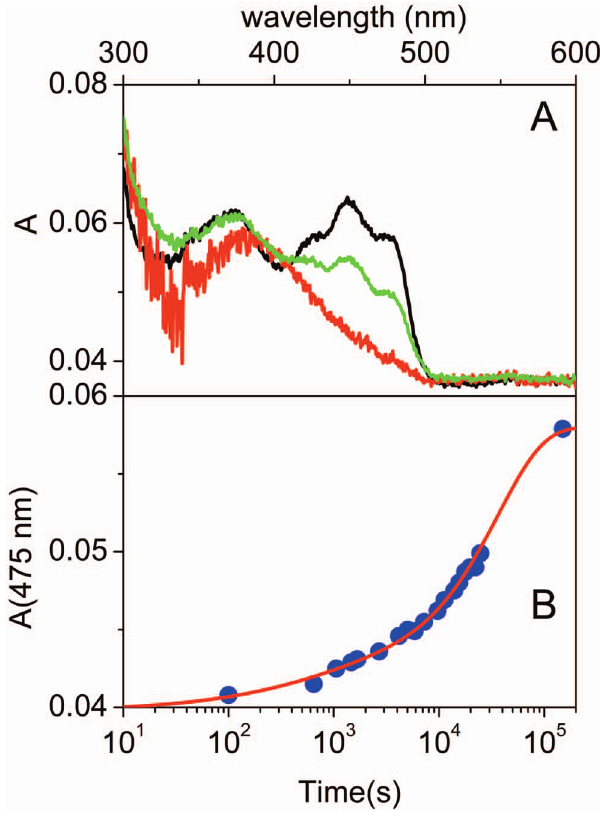
Figure 2. Dark recovery kinetics of dried YtvA. A. Absorption spectrum for YtvA molecules air-dried on a quartz plate before (black) and after (red) photoconversion with LED465. The green curve reports the absorption spectrum at t=24660 s at 25 u C. After 24 hours the YtvAD spectrum is fully recovered (not shown). B. Dark recovery kinetics of YtvAL to YtvAD followed through the absorbance at 475 nm. The red solid line is the best fit with a double stretched exponential relaxation, with t = 600 6 400 s and b = 0.6 6 0.2 (16%) and t =(3.7 6 0.3) 6 10 4 s and b =1.0 6 0.2 (84%). doi:10.1371/journal.pone.0107489.g002 PLOS ONE |